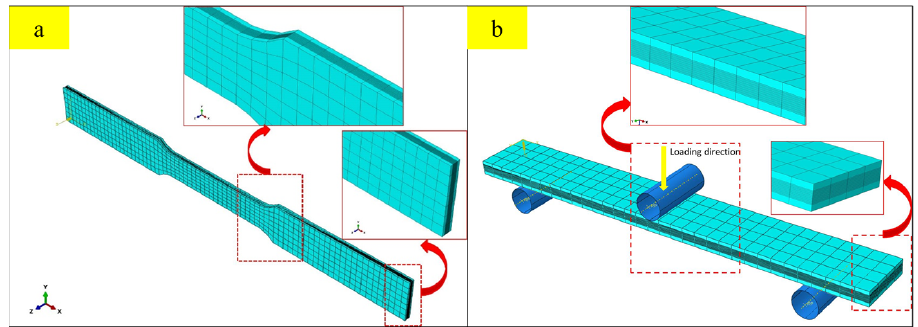
Figure 9. Finite element modelling used in this study: ( a ) modelling of the tensile specimen; ( b ) modelling of the three-point bending specimen.